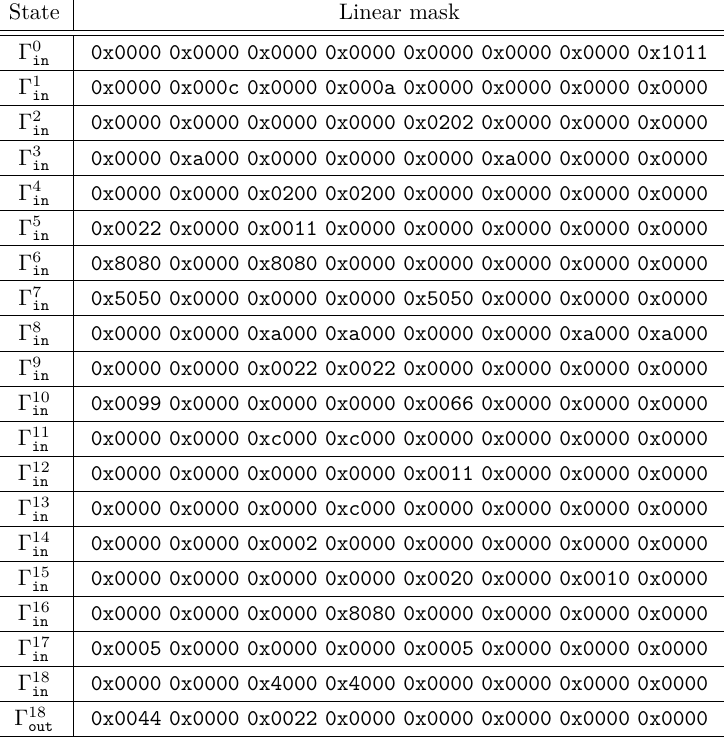
Figure 1: Distribution of characteristics belonging to the 19-round linear approximation. Table 3: 19-round trail with correlation c = 2 − 62